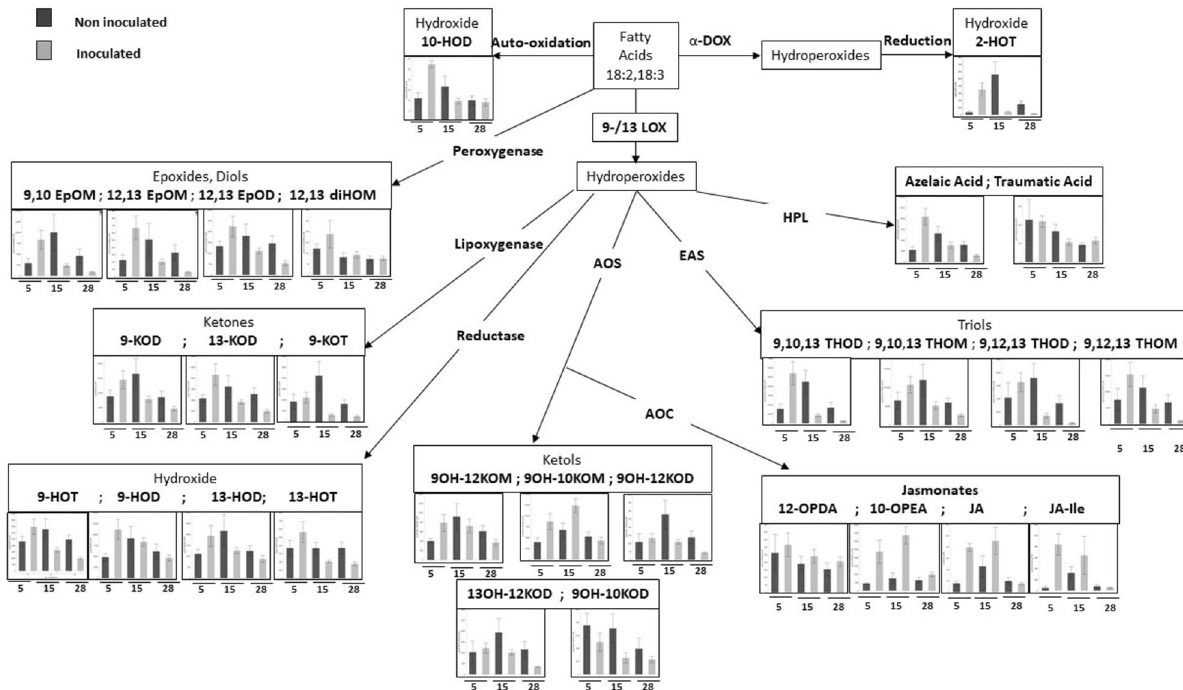
Figure 1. Integrated analysis of the oxylipin profile of tomato roots that were not inoculated (dark gray) or inoculated with M. javanica juveniles (light gray) and collected at different time points (5, 15 and 28 DAI). Abbreviations of oxylipins used in this scheme: 18:2, linoleic acid; 18:3, linolenic acid; 2-HOT, 2(R)-hydroxy-9(Z),12(Z),15(Z)-octadecatrienoic acid; 9,10,13-THOD, 9(S),12(S),13(S)-trihydroxy-10(E),15(Z)- octadecadienoic acid; 9,10,13-THOM, 9(S),12(S),13(S)-trihydroxy-10(E),15(Z)-octadecatrienoic acid; 9,12,13-THOD, 9(S),12(S),13(S)-trihydroxy-10(E)-octadecenoic acid; 9,12,13-THOM, 9(S),12(S),13(S)- trihydroxy-10(E),15(Z)-octadecadienoic acid; 12-OPDA, 12-oxo-10,15(Z)-phytodienoic acid; 10-OPEA, 10-oxo-11-phytoenoic acid; JA, jasmonic acid; JA-Ile, jasmonic acid-isoleucine; 9OH-12KOM, 9-hydroxy-12- oxo-octadecaenoic acid; 9OH-10KOM, 9-hydroxy-10-oxo-octadecaenoic acid; 9OH-12KOD, 9-hydroxy-12- oxo-octadecadienoic acid; 13OH-12KOD, 13-hydroxy12-oxo-octadecadienoic acid; 9OH-10KOD, 9-hydroxy- 10-oxo-octadecadienoic acid; 9-HOT, 9(S)-hydroxy-10(E),12(Z),15(Z)-octadecatrienoic acid; 9-HOD, 9(S)-hydroxy-10(E),12(Z)-octadecadienoic acid; 13-HOD, 13(S)-hydroxy-9(Z),11(E)-octadecadienoic acid; 13-HOT, 13(S)-hydroxy-9(Z),11(E),15(Z)-octadecatrienoic acid; 9-KOD, 9-keto-10(E),12(Z)-octadecadienoic acid; 13-KOD, 13-keto-9(Z),11(E),15(Z)-octadecatrienoic acid; 9-KOT, 9-keto-10(E),12(Z),15(Z)- octadecatrienoic acid; 9,10 EpOM, 9(R),10(S)-epoxy-12(Z)-octadecenoic acid; 12,13 EpOM, 12(R),13(S)- epoxy-9(Z)-octadecenoic acid; 12,13 EpOD, 11(S),12(S)-epoxy-13(S)-hydroxy-9(Z),15(Z)-octadecadienoate; 12,13 diHOM, (±)-threo-12,13-dihydroxy-9(Z)-octadecenoic acid; 10 HOD, (8E,12Z)-10-hydroxy-8,12 octadecadienoic compared to noninoculated roots, followed by a clear reduction 15 and 28 DAI. A similar pattern of induction 5 DAI was detected with the α-DOX product 2(R)-hydroxy-9(Z),12(Z),15(Z)-octadecatrienoic acid (2-HOT). Measurement of oxylipins of the 9-allene oxide synthase (9-AOS) pathway—10-oxo-11-phytoenoic acid (10- OPEA) produced from C18:2, and 9-hydroxy-10-oxo-octadecaenoic acid (9OH-10KOM) and 9OH-12KOM